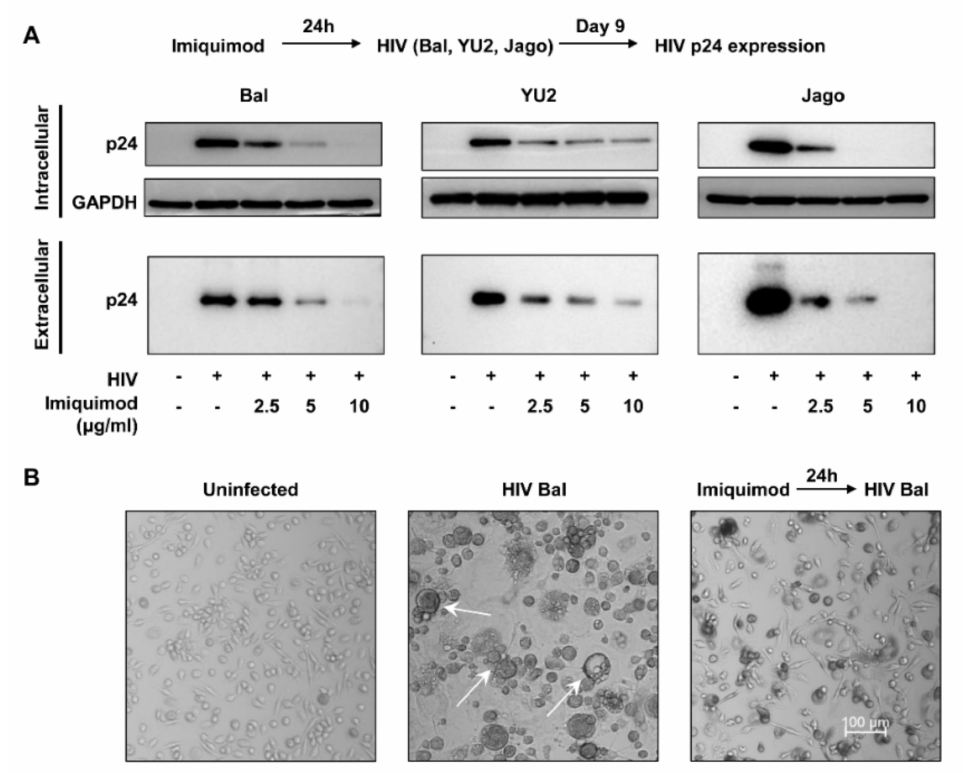
Figure 2. Imiquimod inhibits HIV p24 expression. ( A ) Macrophages were treated with or without imiquimod at indicated concentrations for 24 h prior to infection with different HIV strains (Bal, YU2, and Jago). Cellular and culture supernatant proteins were collected on day 9 post-infection and subjected to the Western blot assay for HIV p24 expression. ( B ) The morphology of unin- fected macrophages comparing with HIV Bal-infected cells pretreated with or without imiquimod (10 µ g/mL) was photographed by a confocal microscope (Nikon, A1R, Tokyo, Japan) on day 9 post-infection. The arrows indicate HIV-induced giant syncytium formation in